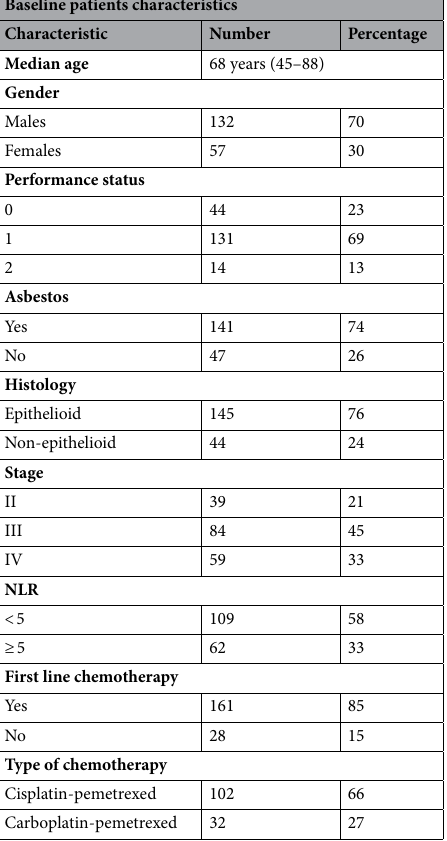
Table 1. Patients characteristics. NLR Neutrophil to lymphocyte